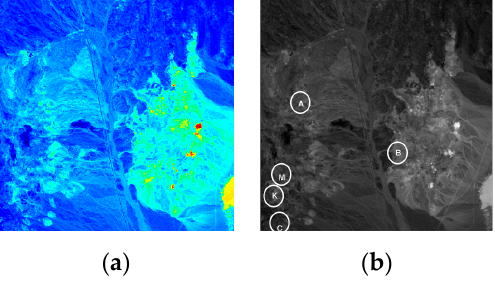
Figure 4. ( a ) Cuprite Airborne Visible/Infrared Imaging Spectrometer sensor (AVIRIS) image; ( b ) Spatial positions of A, B, C, K, and M.